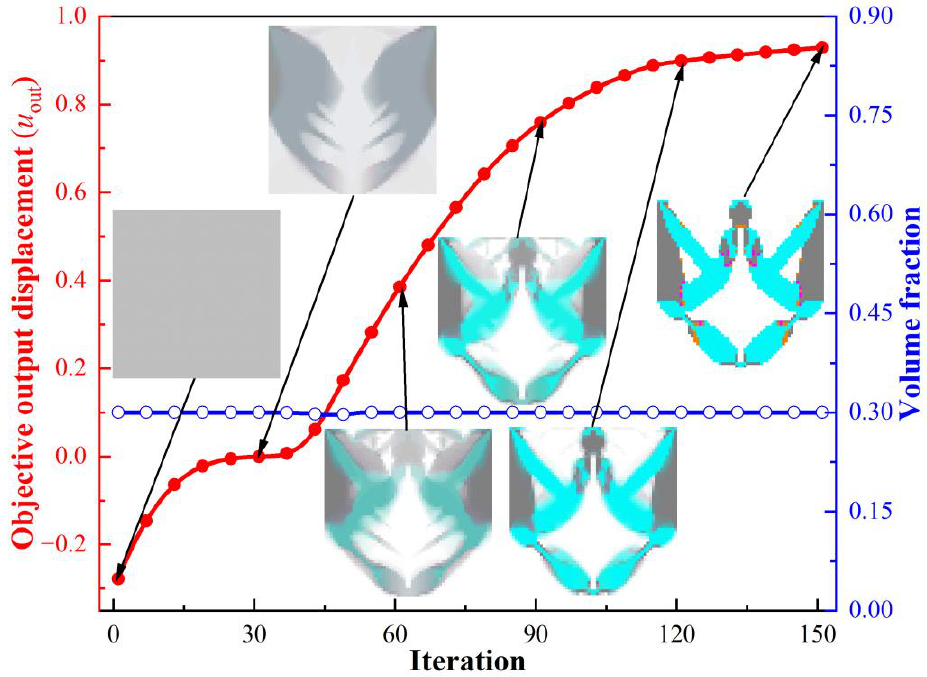
Figure 6. Iteration histories of objective output displacement and volume faction of the HL-DIM.